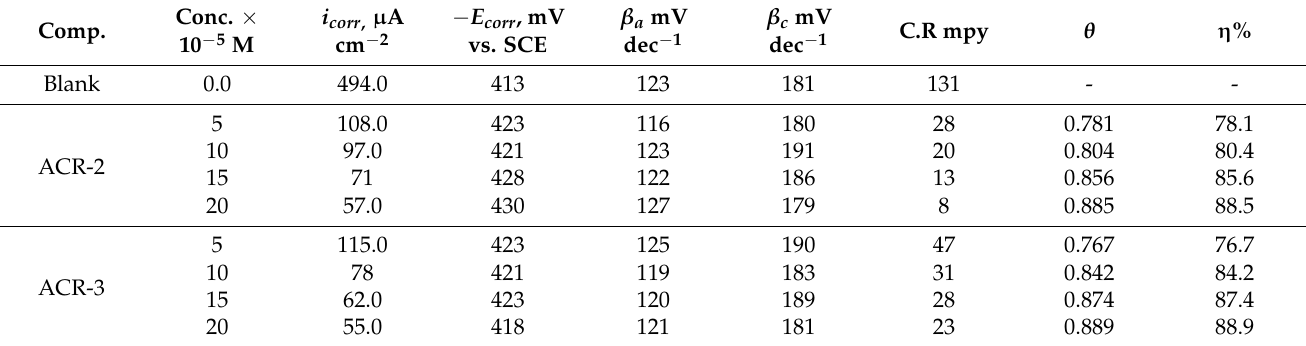
Figure 13. Plots of PP of Cu dissolution with and without different doses of ACR-3. Table 6. Corrosion parameters obtained from potentiodynamic polarization of Cu in 1.0 M HNO 3 containing numerous doses of